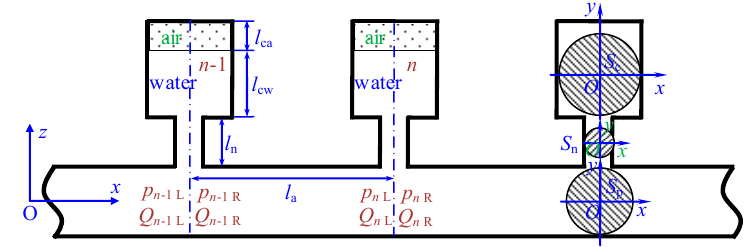
Figure 1. Sketch of the seawater pipe system with Helmholtz resonators (HRs) mounted periodically.